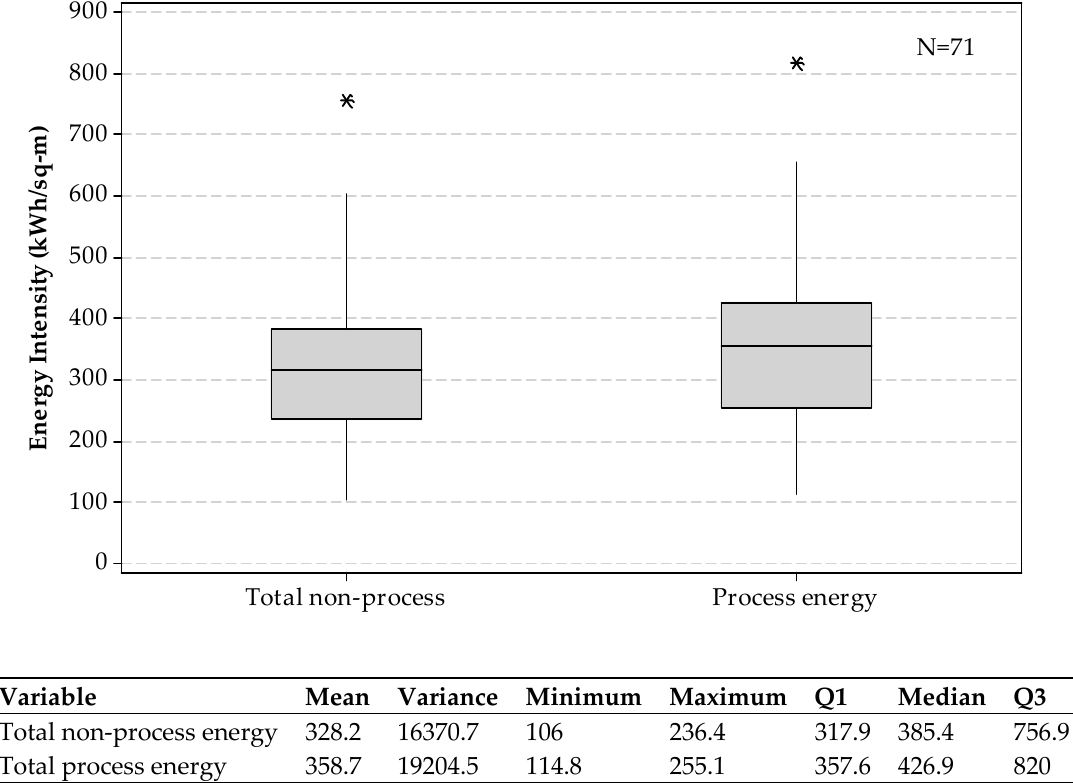
Notes: * represents the outliers.